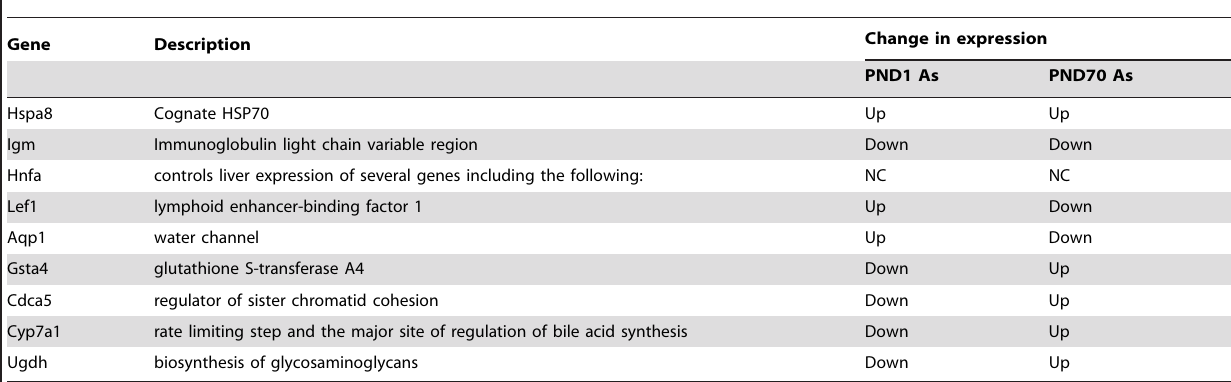
Table 1. Network analysis of 51 gene